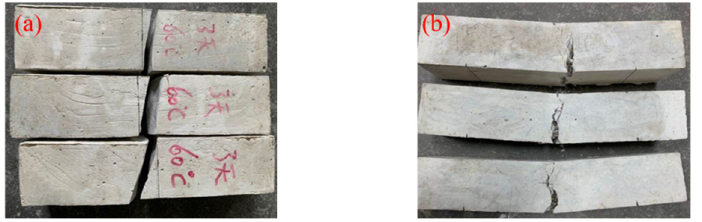
Figure 7. Morphology after flexural test of HMGC. ( a ) HMGC without steel fibers cured at 60 °C for three days; ( b ) HMGC with steel fibers.